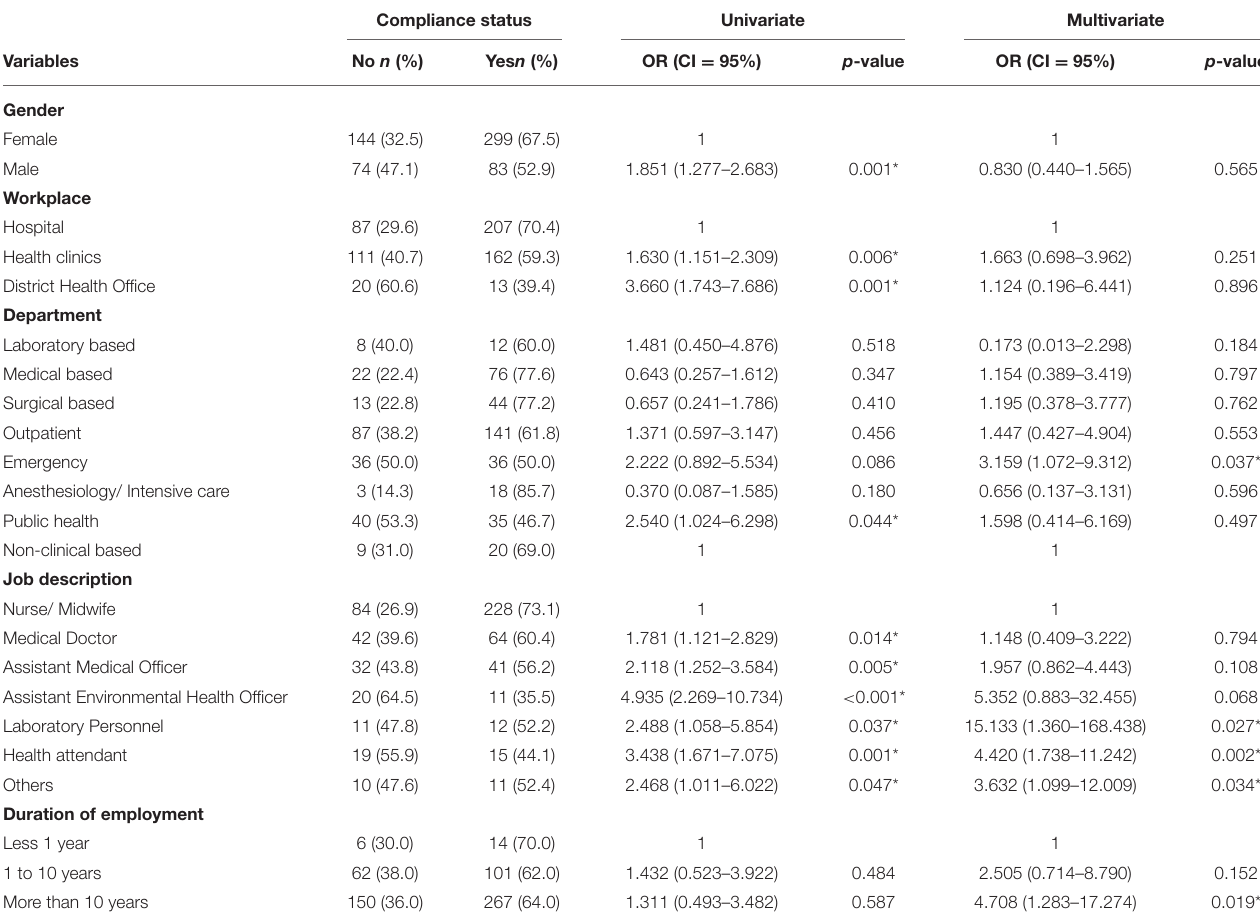
TABLE 3 | Demographic and occupational factors associated with compliance status among healthcare workers. Compliance status Univariate